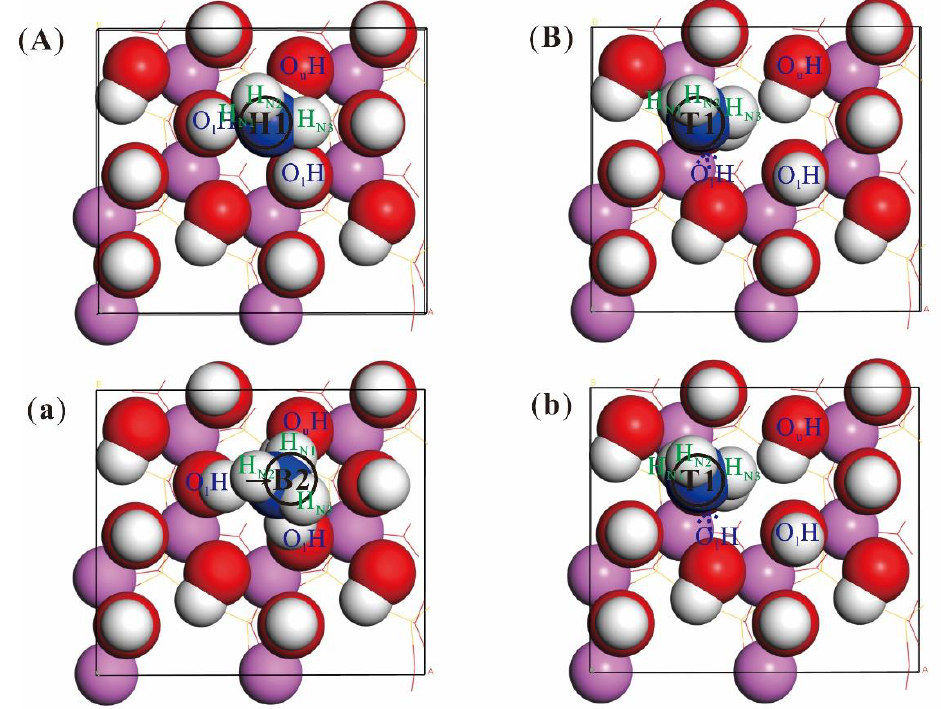
Figure 4. Top view of the positional change of NH 3 molecules before and after adsorption. ( A , a ) the positional change of NH 3 before and after adsorption at the “Hollow1” of the kaolinite (001) surface; ( B , b ) the positional change before and after adsorption at the “Top1” (the white ball: H; the red ball: O; the purple ball: Al).